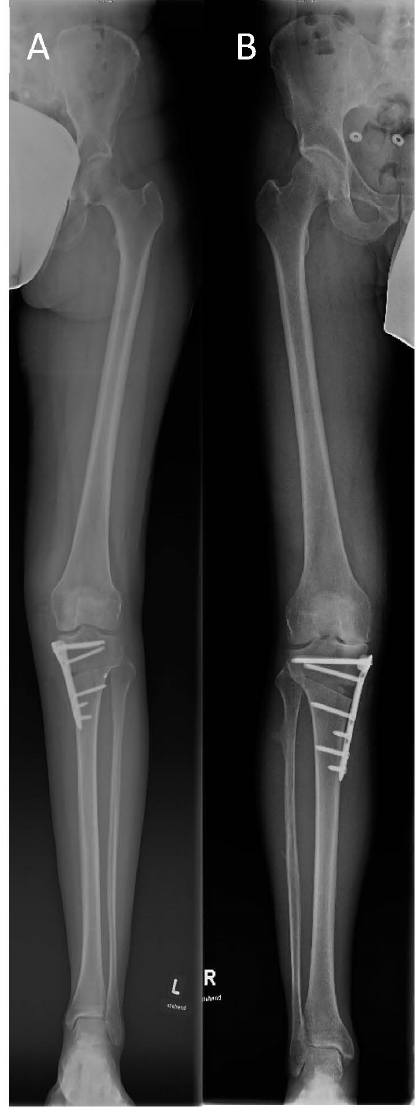
Figure 2. Full-length leg X-ray after HTO and open-wedge osteotomy using an LOQTEQ ® HTO ( A ) and a TomoFix TM plate ( B ), plate ( A ) and a TomoFix TM plate ( B ), respectively.